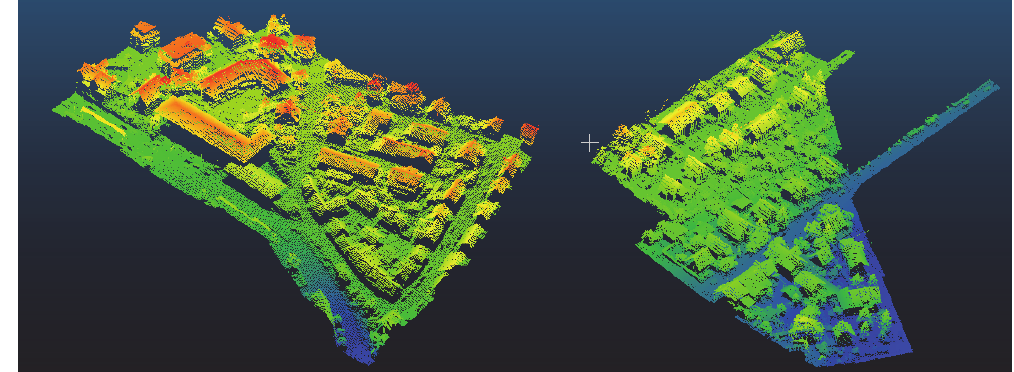
Figure 3.Testing set: The color blue to red represents the z values of the points.